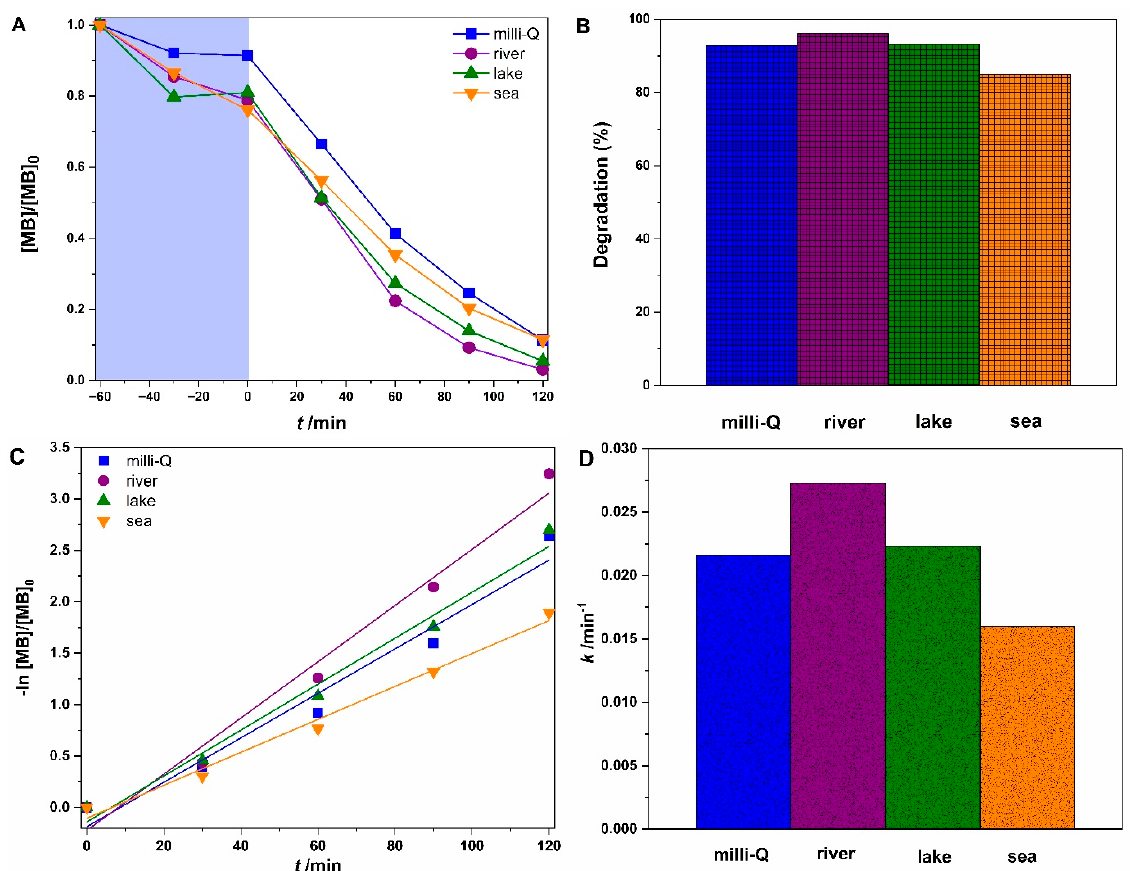
Figure 5. Effect of different water matrices (milli-Q water, river water, seawater, and lake water) on the ( A ) adsorption (stirring in the dark) and photodegradation efficiency of MB dye using rGO/TiO 2 nanocomposite under solar-like irradiation, ( B ) degradation efficiency of MB, ( C ) the − ln [MB]/[MB] 0 versus reaction time, and ( D ) kinetic rate constants of photocatalytic reaction in different environmental water matrices.